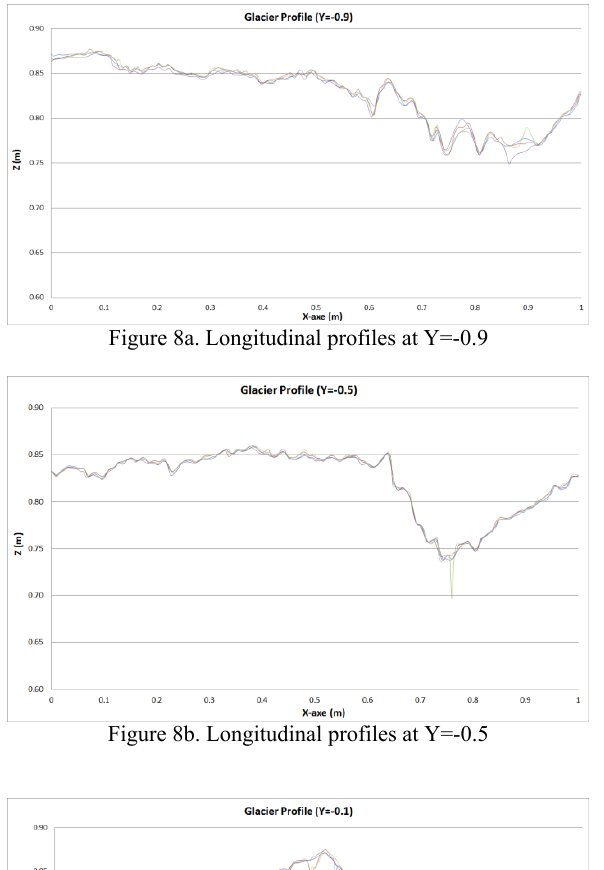
Figure 8a. Longitudinal profiles at Y=-0.9